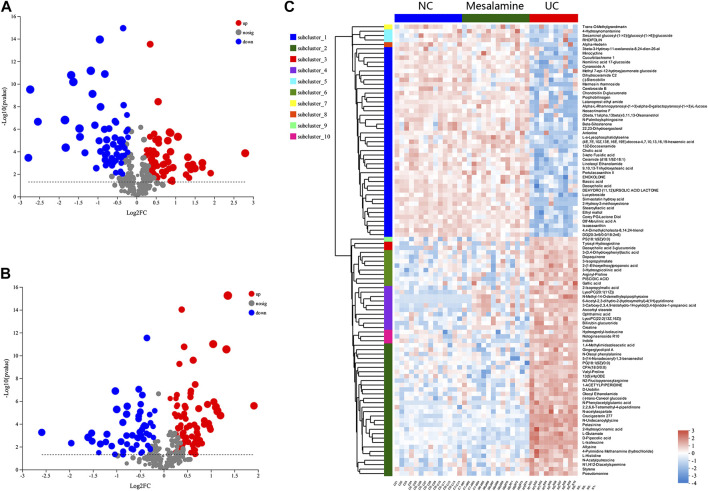
Significantly changed metabolites among groups. (A) Volcano plots of differential metabolites between UC group and NC group, grey dots represent metabolites with no significant change, red dots represent up-regulated metabolites and green dots represent down-regulated metabolites. (B) Volcano plots of differential metabolites between UC group and mesalamine group, grey dots represent metabolites with no significant change, red dots represent up-regulated metabolites and green dots represent down-regulated metabolites. (C) Hierarchical cluster of 102 candidate metabolites. The color indicates the relative expression level of metabolites in this group of samples, red indicates up-regulated and blue indicated down-regulated.